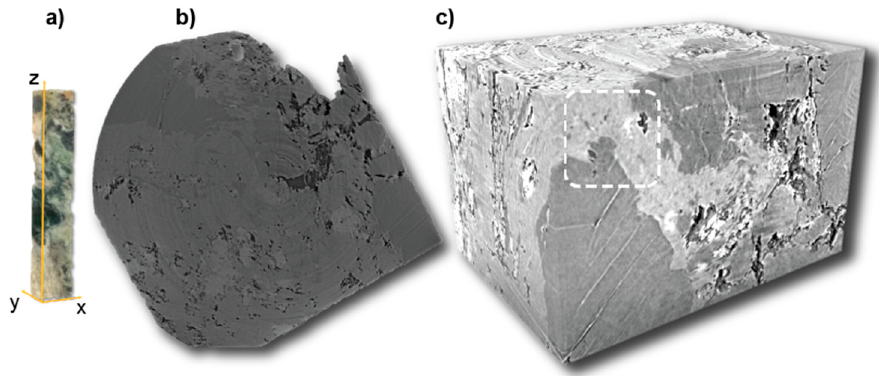
Figure 5. Sample 2 (S2). ( a ) Sample cut for tomographic scanning; ( b ) example of one single slice generated (1800 scans in total); ( c ) volume rendering (7.7 mm 3 ) obtained by synchrotron radiation X-ray microtomography (rendering performed using the commercial software VGStudio Max 2.0 (Volume Graphics, Heidelberg,